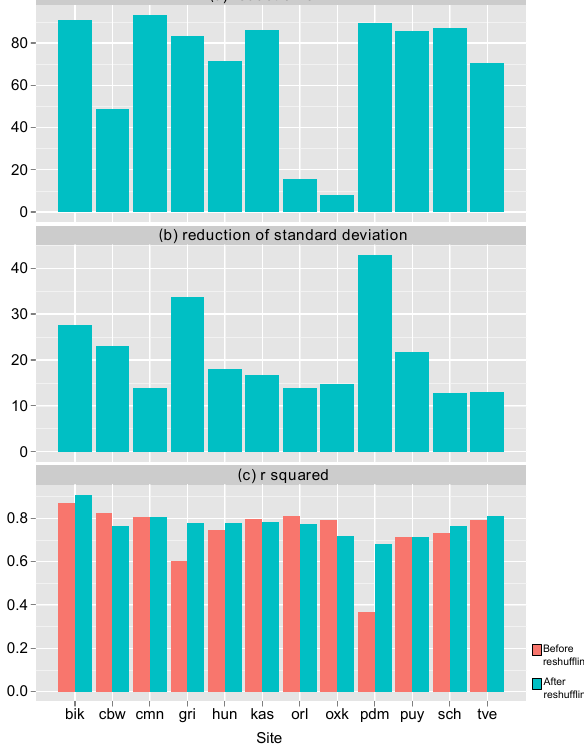
Fig. 10. Summary barplot of the error reduction (in %) (a) , reduc- tion of random error (in %) (b) and correlation before (red) and after the reshuffling was applied (cyan) (c) . The results show averages for daytime (10:00–18:00 local